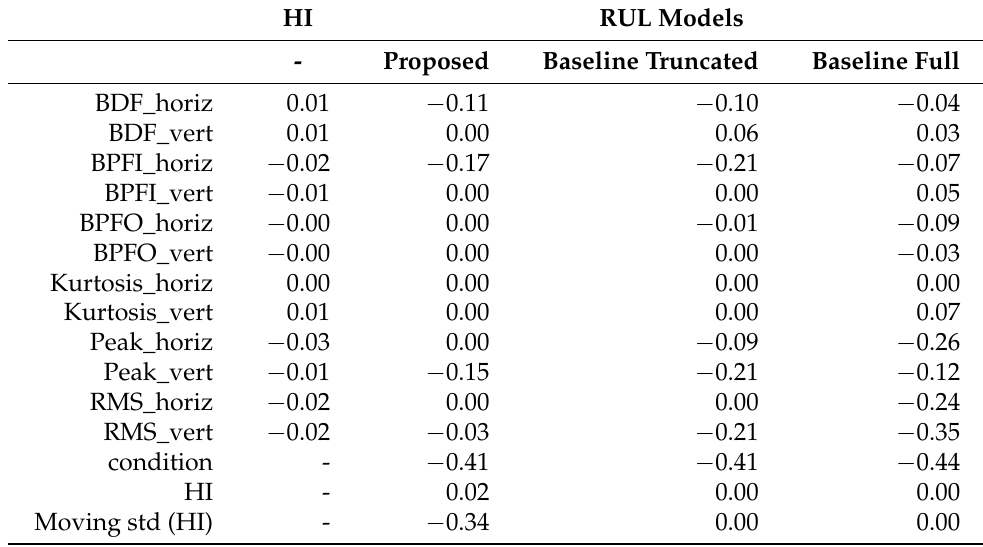
Table 5. Coefficients for PHM